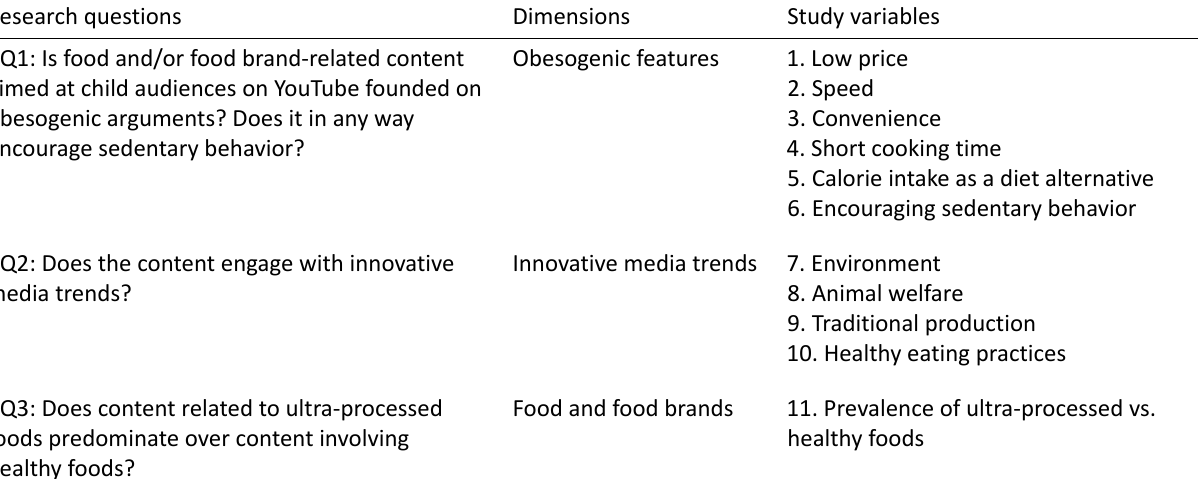
Table 2. Congruence between research questions, dimensions, and study